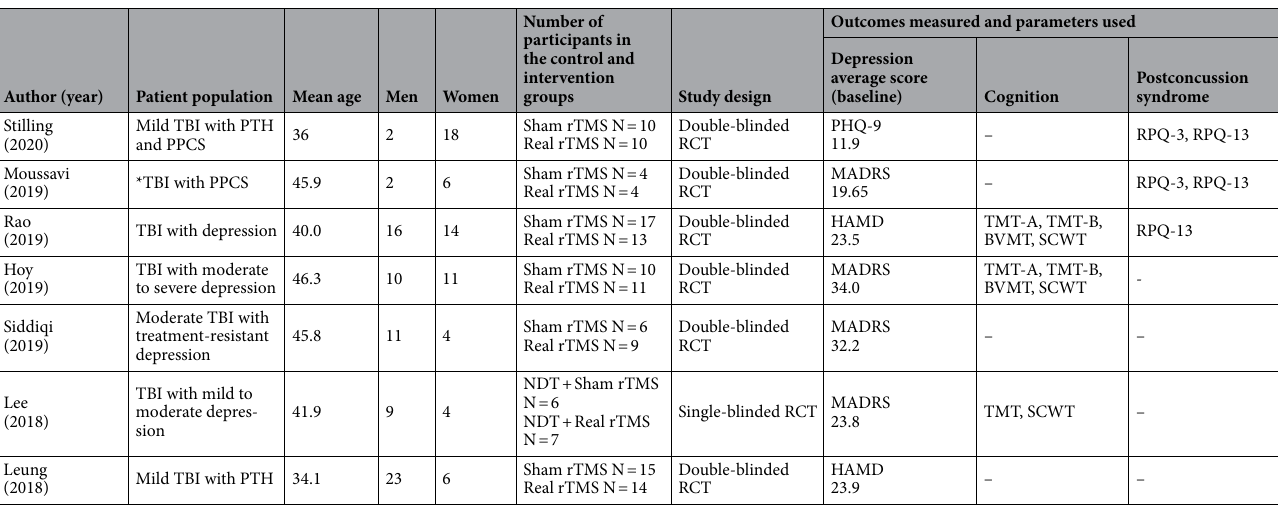
Table 1. Summary of study characteristics and outcomes measured. TBI traumatic brain injury, PTH posttraumatic headache, PPCS persistent postconcussion syndrome, NDT neurodevelopmental therapy, rTMS repetitive transcranial magnetic stimulation, RPQ Rivermead Post-Concussion Symptom Questionnaire, MADRS Montgomery–Asberg Depression Rating Scale, HAMD Hamilton Rating Scale for Depression, PHQ-9 Patient Health Questionnaire 9, TMT Trail Making Test, BVMT Brief Visuospatial Memory Test, SCWT Stroop Color Word Test, RCT randomized controlled trial. *Only people having severe postconcussion